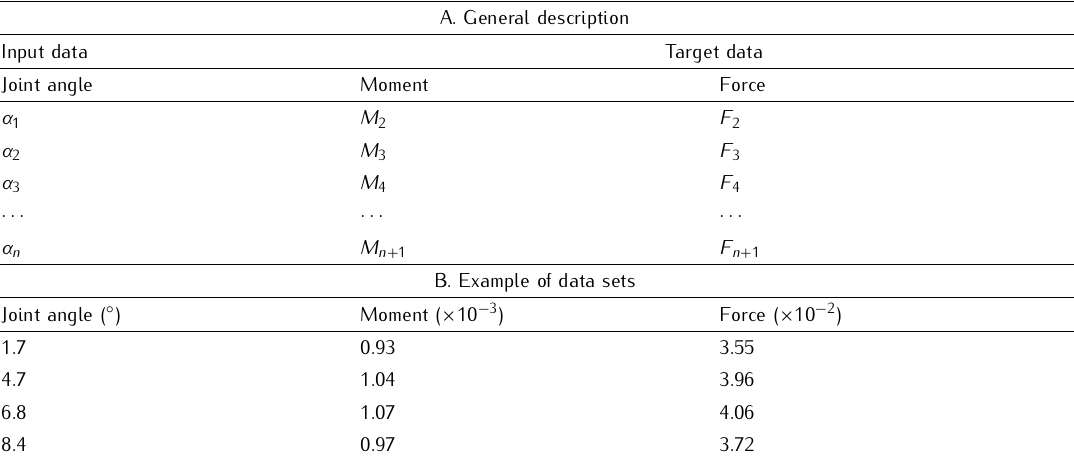
Table 1. Table of training data of the joint angle, the muscle force and the muscle